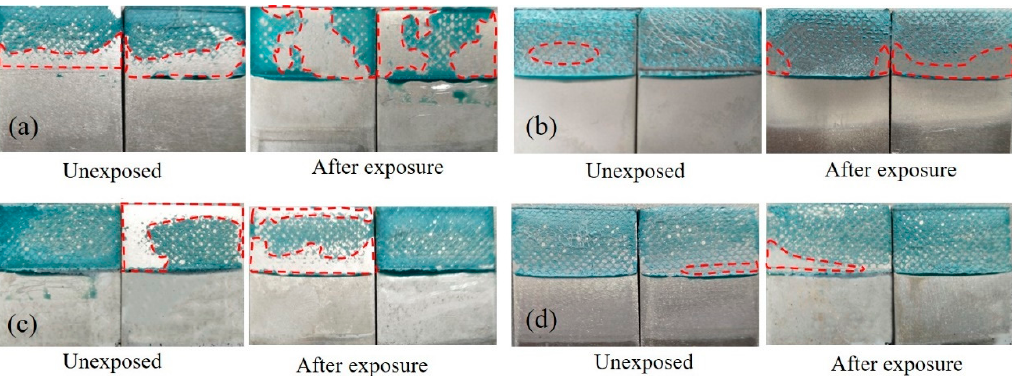
Figure 6. Effect of surface morphologies on failure modes after exposure: ( a ) sandpaper abraded, ( b ) sandblasting, ( c ) chemical etching, and ( d ) PAA.